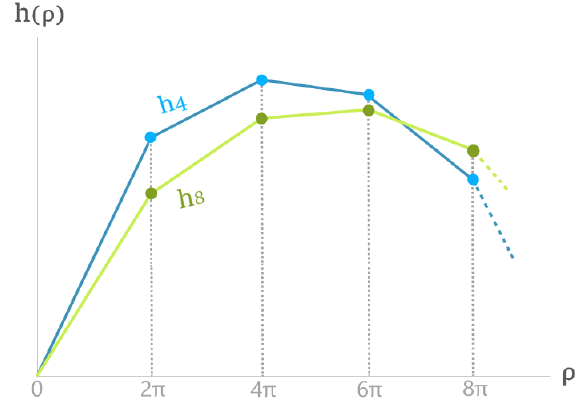
Figure 2 . An example of the linear functions h 4 ; 8 ( (cid:26) ) in Class I backgrounds. These piecewise functions decrease in slope along (cid:26) and at least one of them (or both) has to vanish at the end of the dimension, (cid:26) f